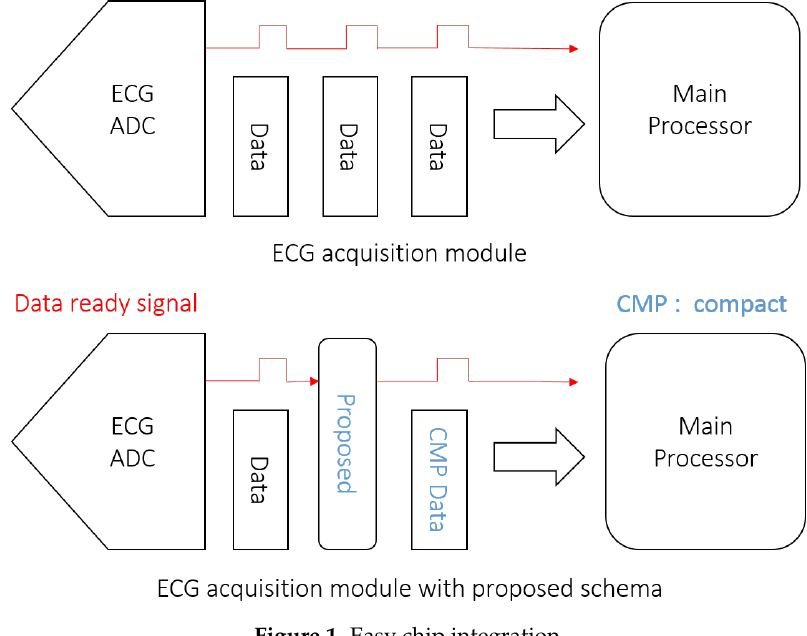
Figure 1. Easy chip integration.